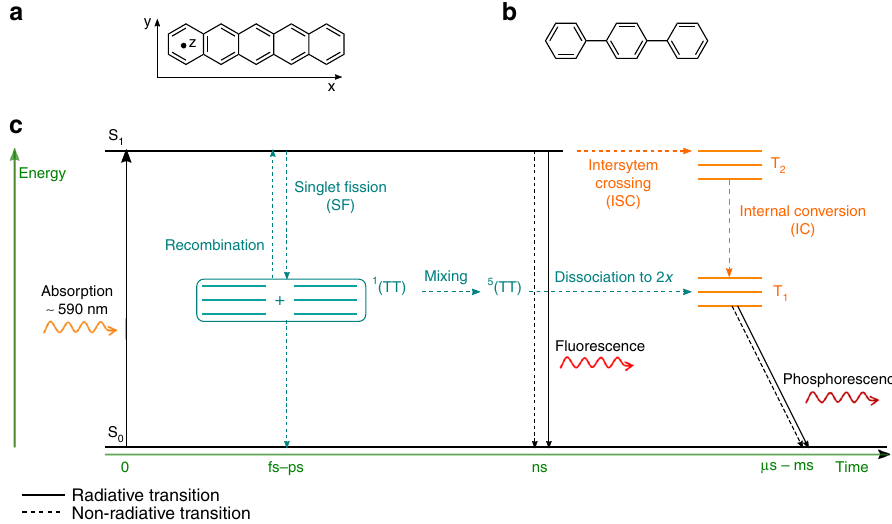
Fig. 1 Molecular structures and Jablonski diagram with timescale. a Molecular structure of pentacene with corresponding ZFS axes. b Molecular structure of p -terphenyl. c As a result of photoexcitation, pentacene generates triplets via two distinct mechanisms. Coupled pentacene molecules undergo fast (fs – ps) SF leading to two strongly coupled 1 (TT) states which can then populate the quintet state (teal). These can recombine or ultimately dissociate into free triplets. Alternatively, individual pentacene molecules can transition to triplet states via ISC (orange), which is energetically less favourable due the required spin- fl ip and therefore occurs on slower timescales